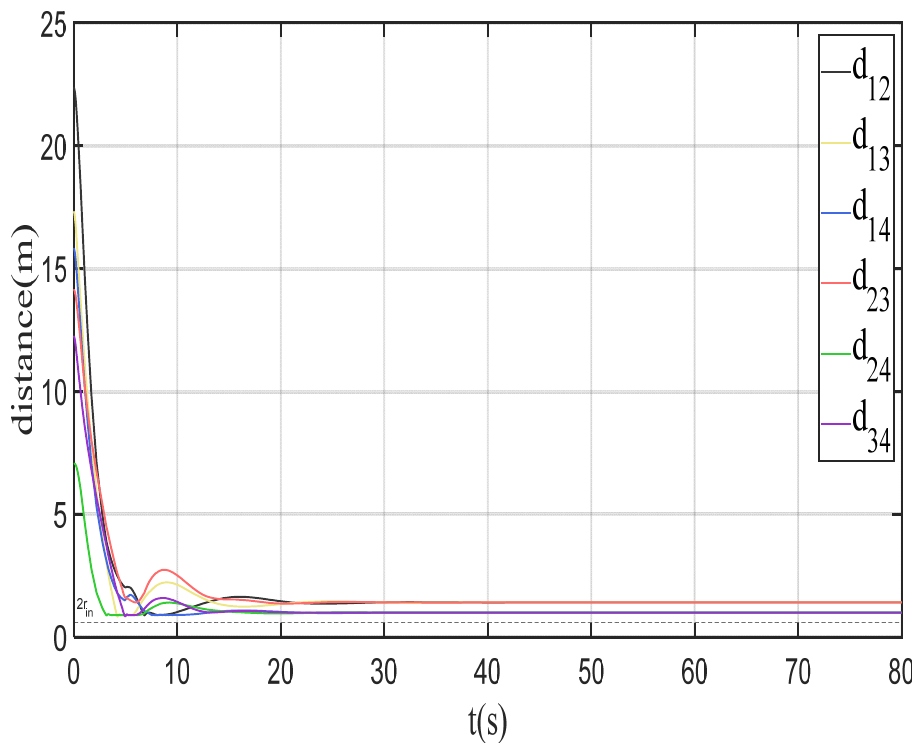
Figure 7. The distance between any two UUVs of the formation with collision avoidance.